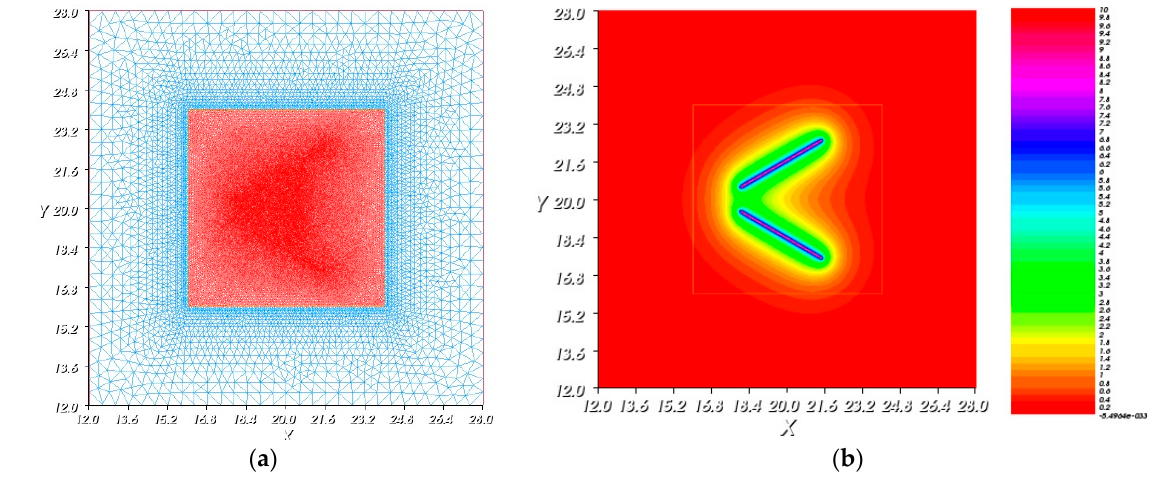
Figure 4. Finite element mesh and calculated potential contour of clay–electrolyte system. ( a ) Computation mesh. ( b ) Calculated nephogram.